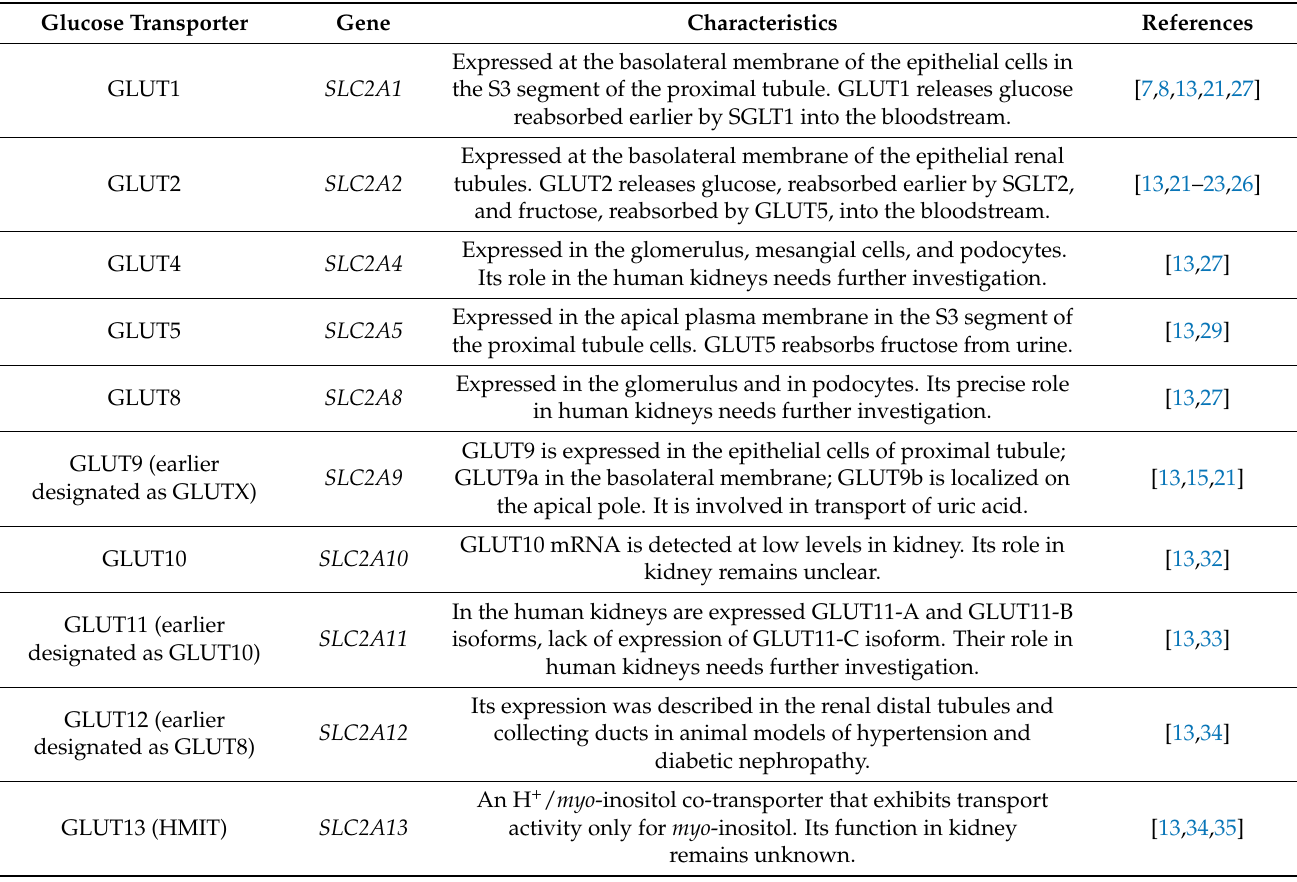
Table 1. Characteristics of sodium-independent glucose transporters (GLUT proteins) in the healthy human kidneys. Glucose Transporter Gene